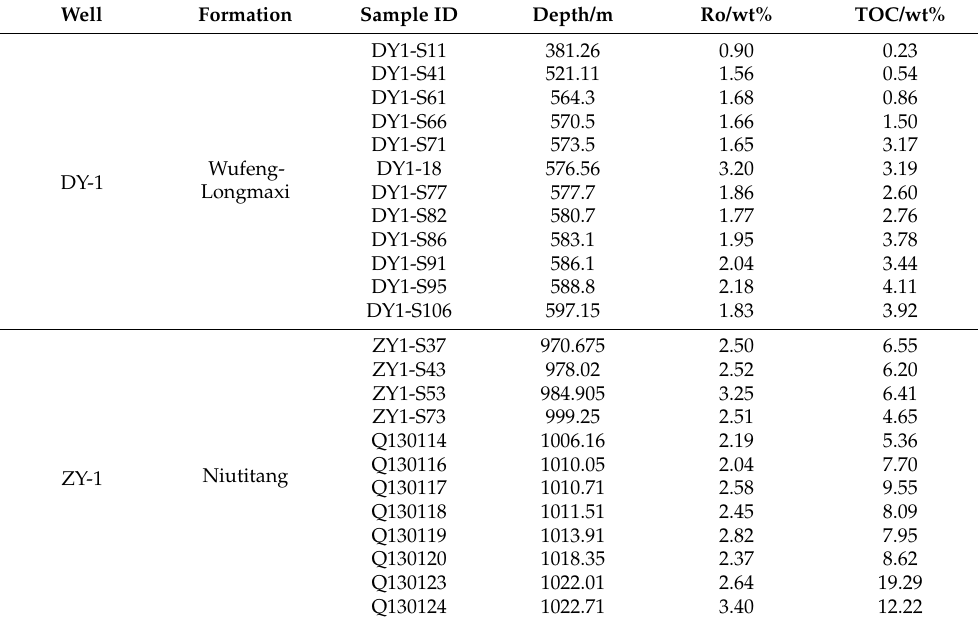
Table 1. Ro and TOC of the Wufeng-Longmaxi and Niutitang Formations in northern Guizhou